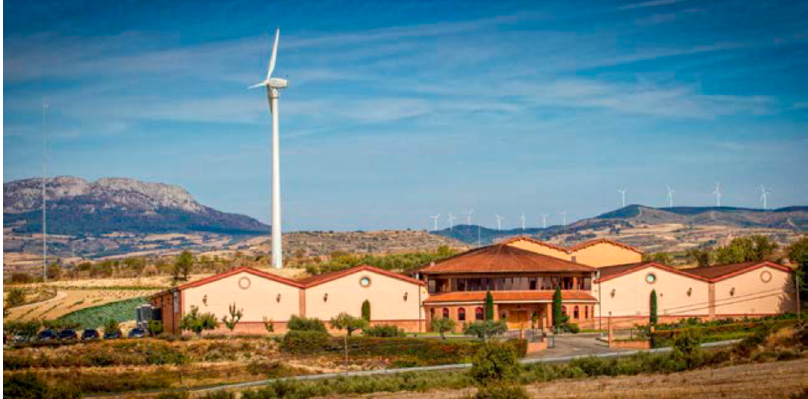
Figure 1. Wind Turbine of 100 kW placed in Bodegas Pierola wine cellar (Moreda, Araba, Spain).